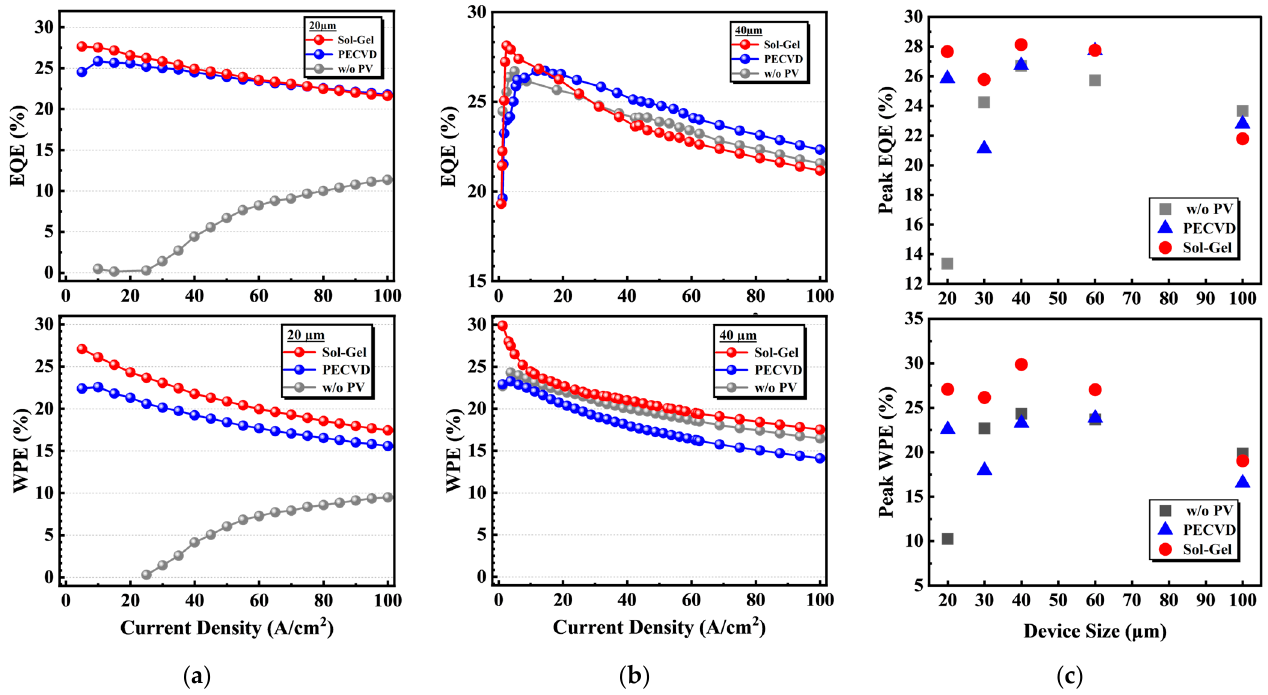
Figure 5. EQE and WPE curves of Micro-LEDs of S1, S2, and S3 for ( a ) 20 × 20 μ m and ( b ) 40 × 40 μ m; ( c ) peak EQE and WPE of S1, S2, and S3 for different sizes. ( c ) peak EQE and WPE of S1, S2, and S3 for different